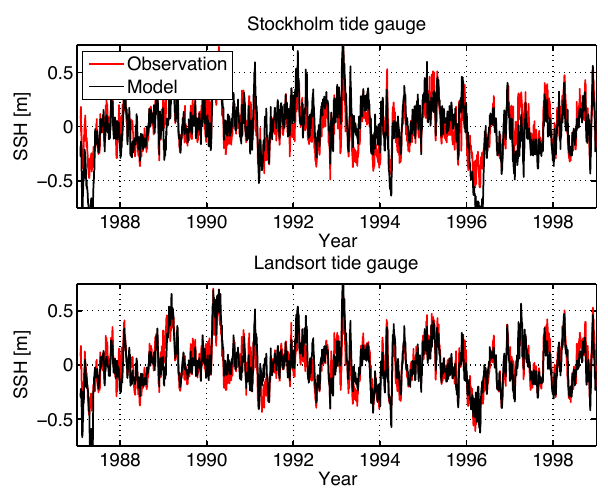
Figure 12. Detrended daily mean sea surface height at Stockholm Fig. 12. Detrended daily mean sea surface height at Stockholm and Landsort (upper and lower and Landsort (upper and lower panel, respectively). The black (red) panel, respectively). The black (red) line denotes observed (simulated) heights. line denotes observed (simulated)